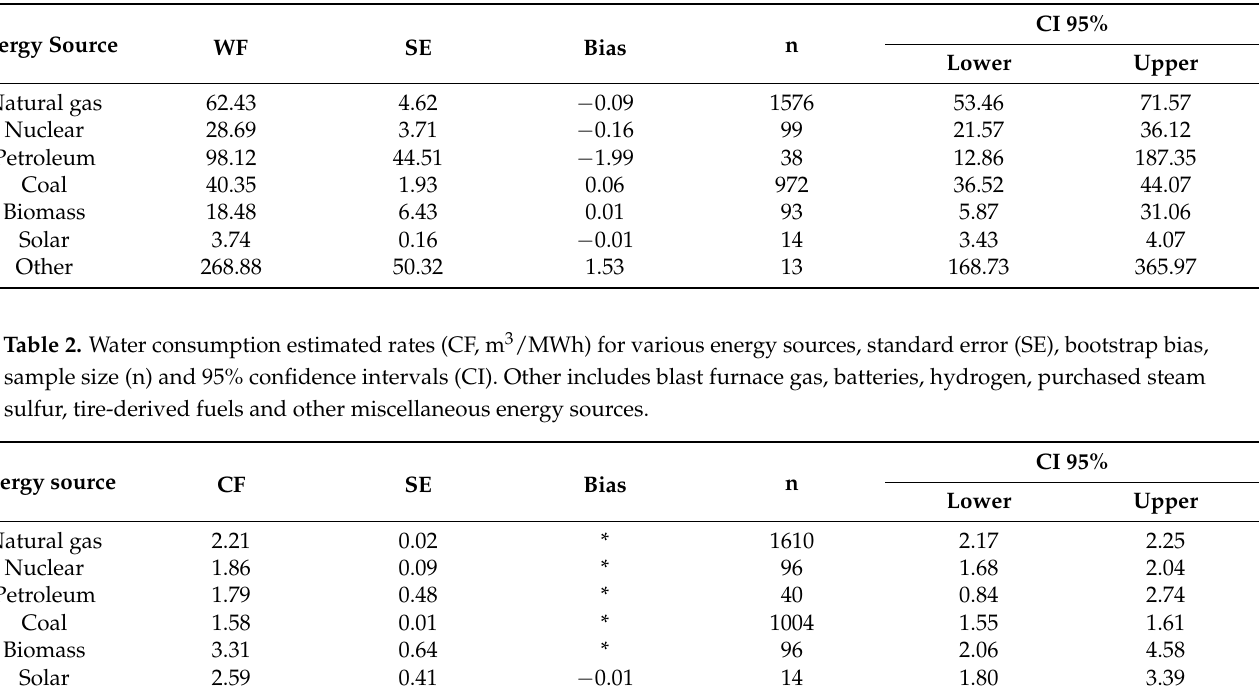
Table 1. Water withdrawal estimated rates (WF, m 3 /MWh) for various energy sources, standard error (SE), bootstrap bias, sample size (n) and 95% confidence intervals (CI). Other includes all other and other gases (i.e., blast furnace gas, batteries, hydrogen, purchased steam sulfur, tire-derived fuels and other miscellaneous energy sources).